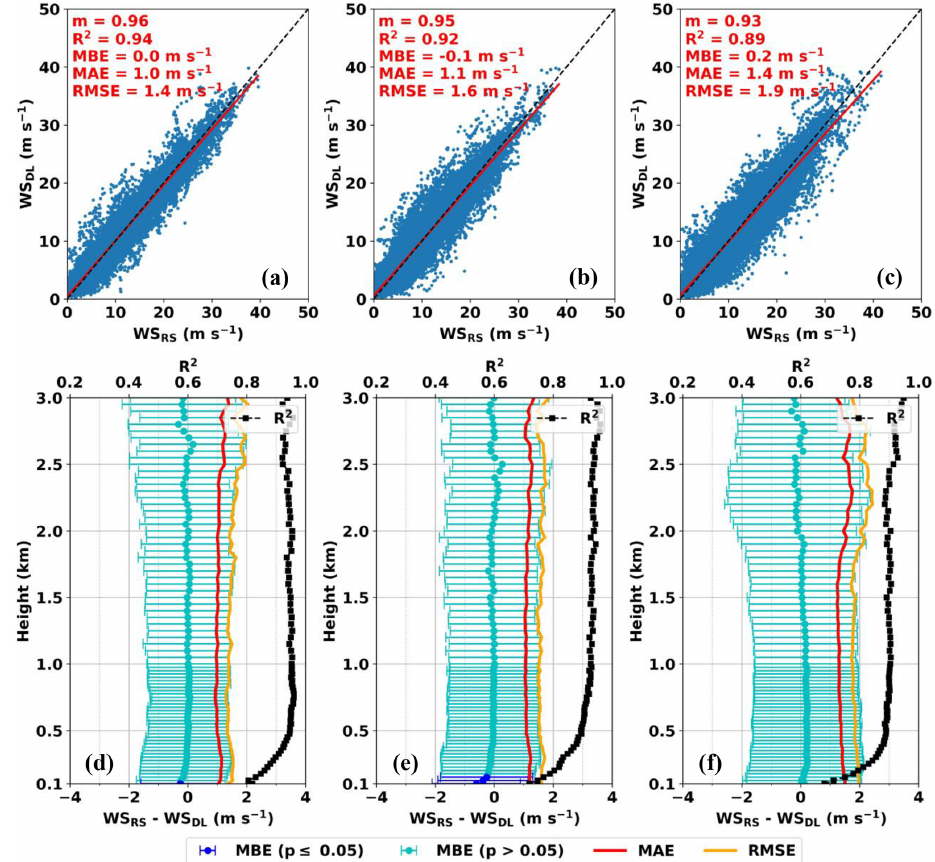
Figure 3. Scatterplots for RS- and DL-measured horizontal wind speed (WS) at three NYSM Profiler Network sites at (a) Buffalo, (b) Albany, and (c) Stony Brook. Vertical profiles of R 2 , MBE with 1 standard deviation error bars, MAE, and RMSE for the same variable are shown for the following sites: (d) Buffalo, (e) Albany, and (f) Stony Brook.